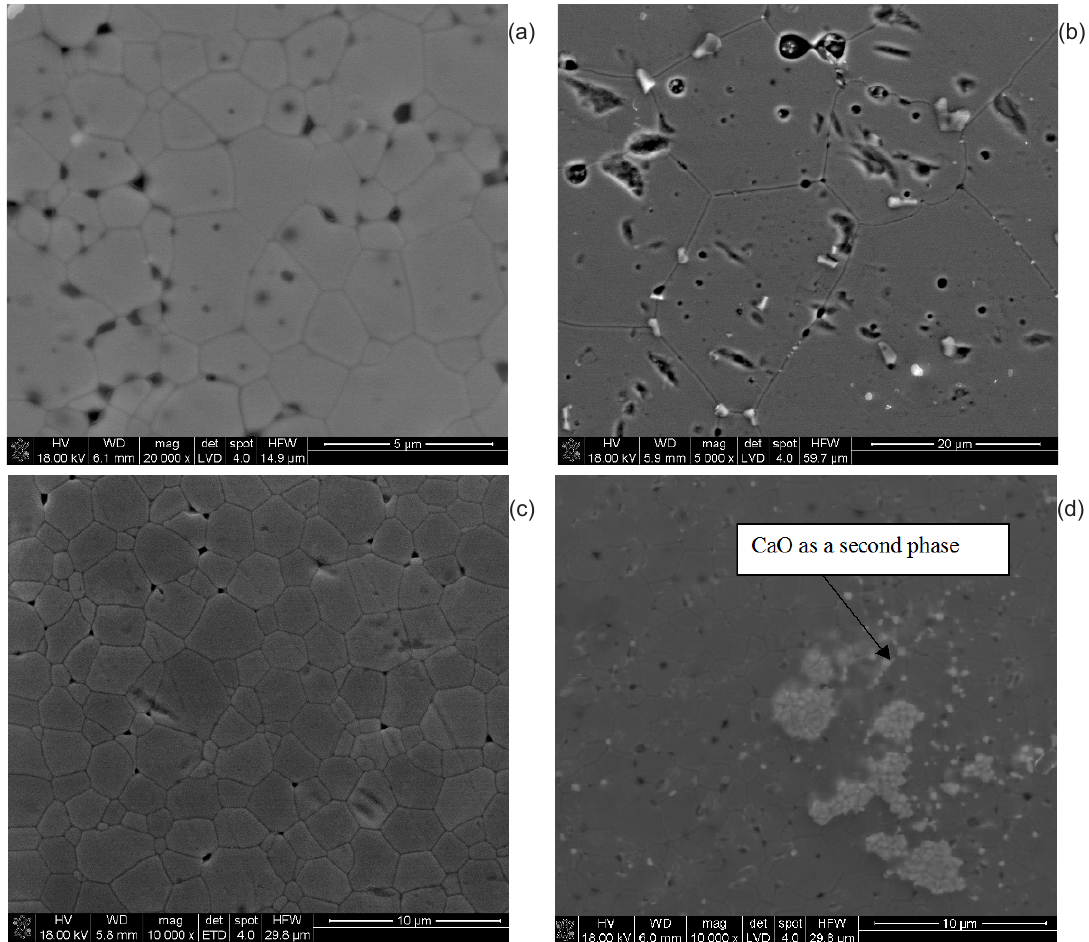
Figure 4. (a) Microstructure of CaZrO involving a 50% mol CaO sintered sample at 1500°C for 2 h. (b) Microstructure of a CaZrO 3 involving 50% mol CaO synthesised by solid state reaction and sintered at 1700°C for 2 h. (c) Microstructure of